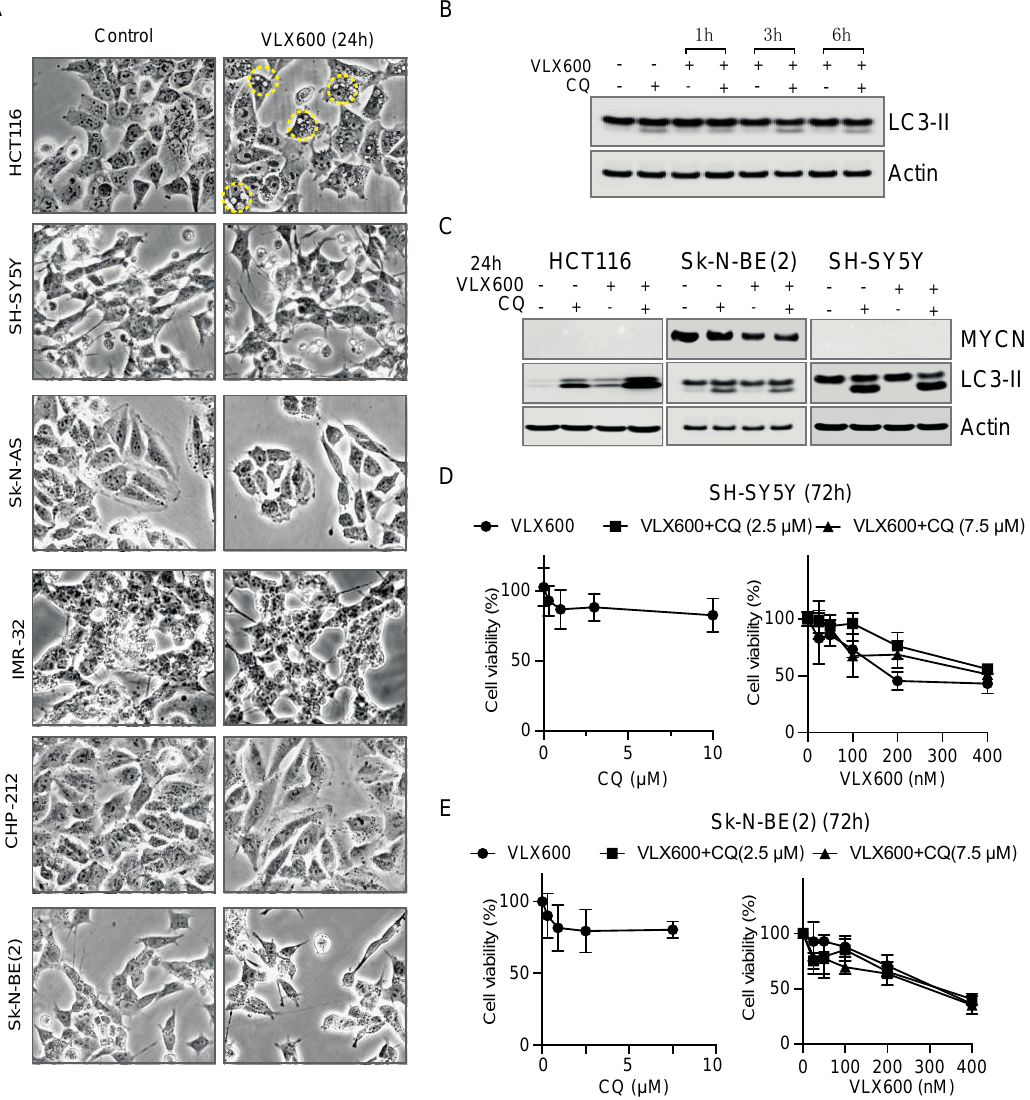
Figure 6. Autophagy as a rescue response to VLX600 was not observed in neuroblastoma cells. ( A ) Images for HCT116, SH-SY5Y, Sk-N-AS, IMR-32, CHP-212 and Sk-N-BE(2) cells treated for DMSO or VLX600 for 24 h. Yellow circles marked in HCT116 cells indicate the large cytoplasmic vesicles. ( B ) Expression levels of LC3-II in Sk-N-BE(2) cells treated with 400 nM VLX600 for indicated